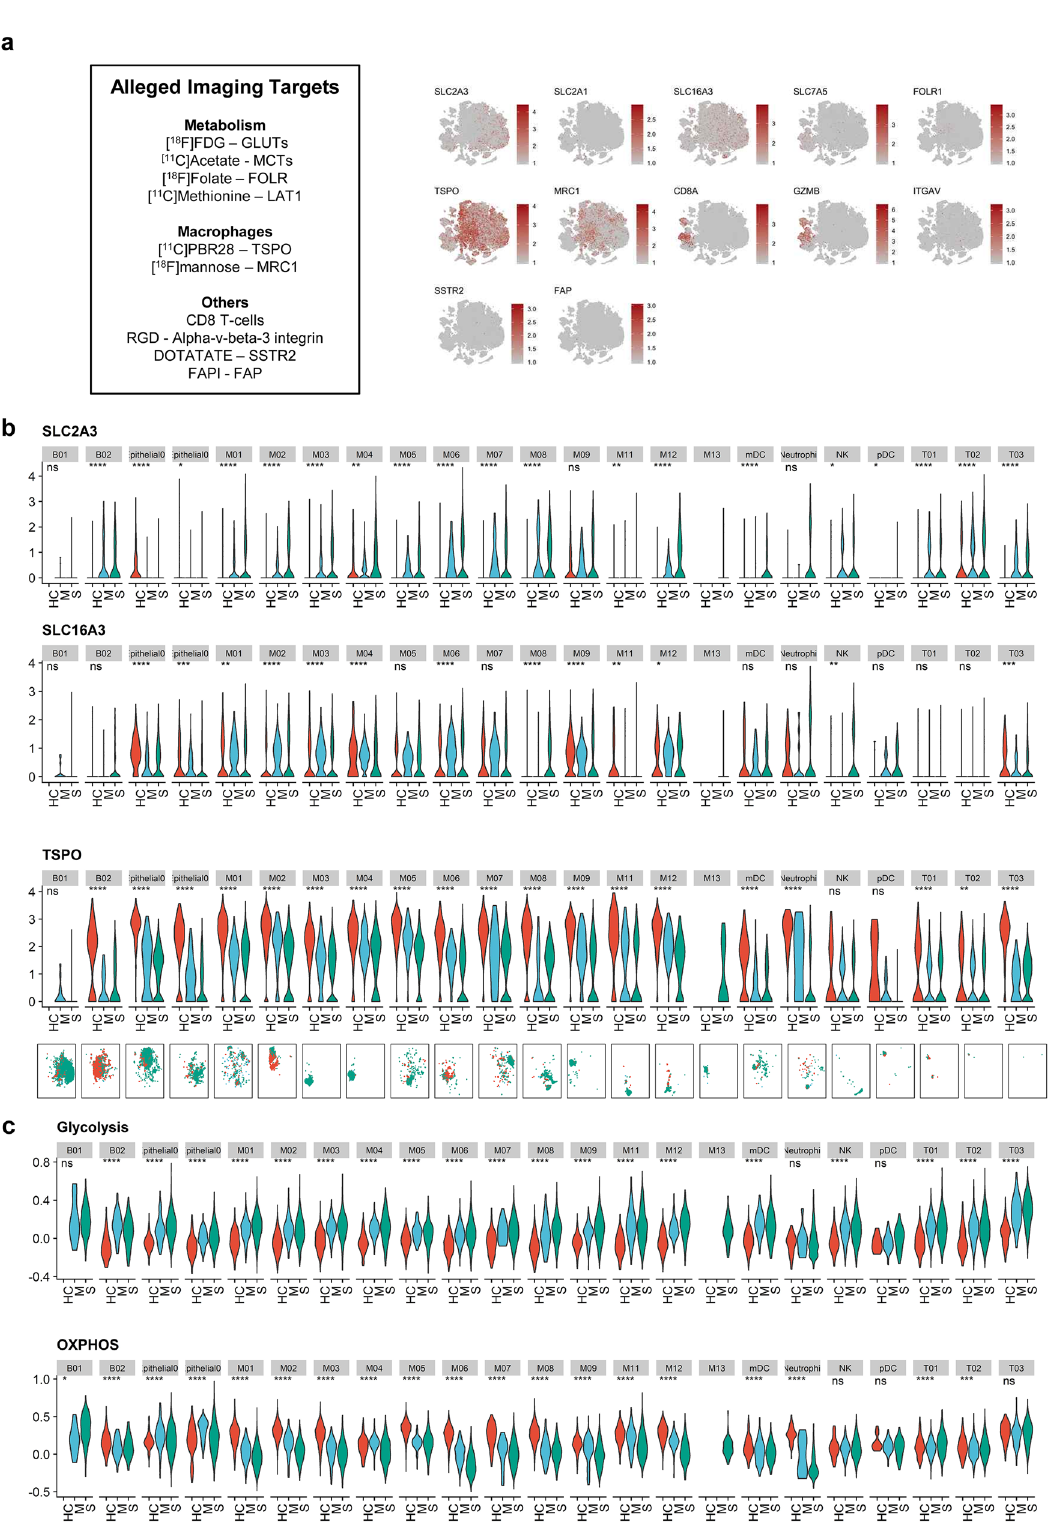
Figure 2. Potentially alleged imaging marker molecules of COVID-19 and metabolic pathways. (a) t-SNE plots showing the expression of several potentially alleged imaging targets on BAL fluid immune cells. The markers indicate the heterogeneous pattern of expression across the immune cells. The last panel indicates subtypes of macrophages abundant in severe COVID-19 patients. (b) Expression levels of SLC2A3 , SLC16A3 , and TSPO across cell clusters of three groups. (ns: p > 0.05; *p < = 0.05; **p < = 0.01; ***p < = 0.001; ****p < = 0.0001) (HC = healthy control; M = moderate COVID-19; S = severe COVID-19) t-SNE plots on the bottom panels show the distribution of each immune cell cluster. (red dot = HC; blue dot = M; green dot = S) (c) Enrichment scores of glycolysis and oxidative phosphorylation (OXPHOS) pathways across cell clusters of three